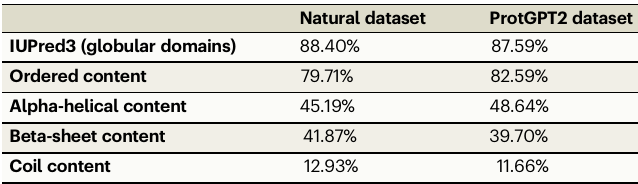
Table 1 | Disorder and secondary structure predictions of the natural and ProtGPT2